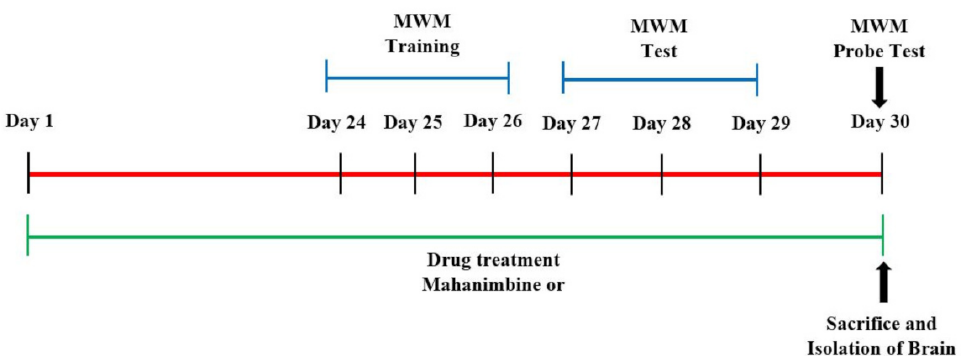
Figure 1. Timeline administration of drug, behavioral assessments, and isolation of brain samples. The groups of young and aged mice were administered mahanimbine (1 or 2 mg/kg, p.o.) or vehicle for 30 days. For MWM analysis, the training sessions were conducted from days 24 to 26. The memory analysis was assessed from day 29 to 30. On day 30, after the probe test, all the animals were sacrificed, and brain tissues were isolated for further biochemical